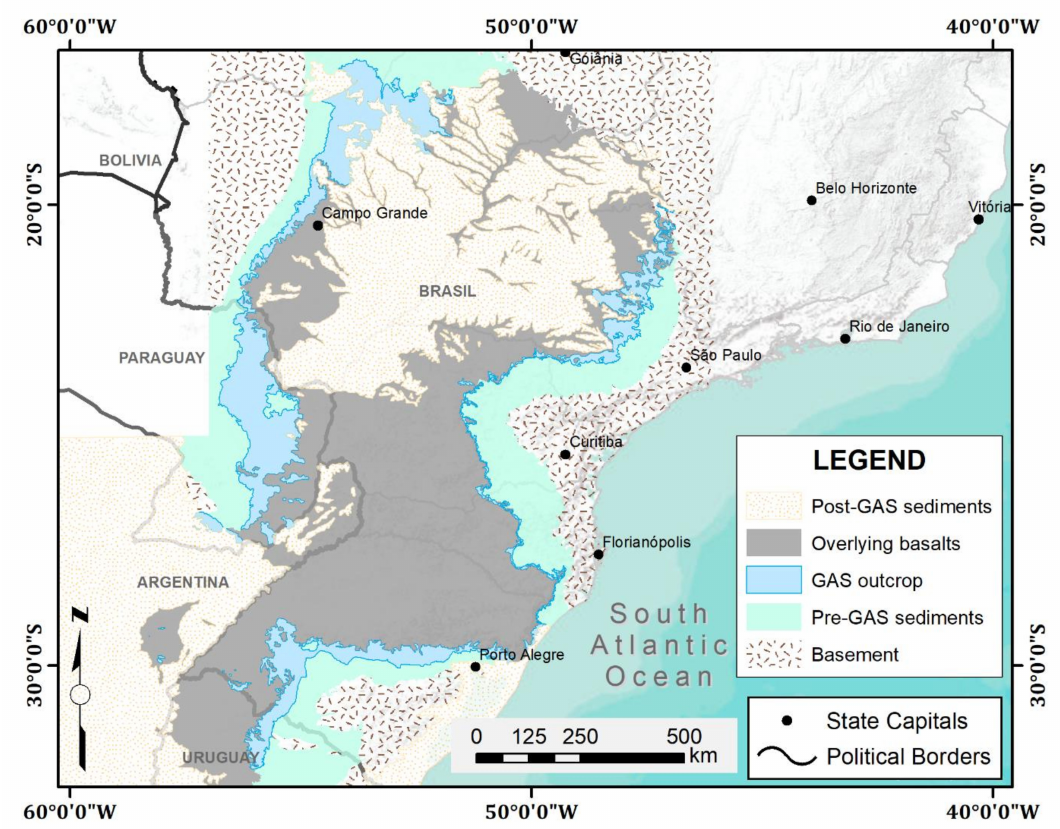
Figure 1. Simplified geologic map showing pre-GAS and post-GAS sediments, GAS outcropping areas and overlying basalts (modified from